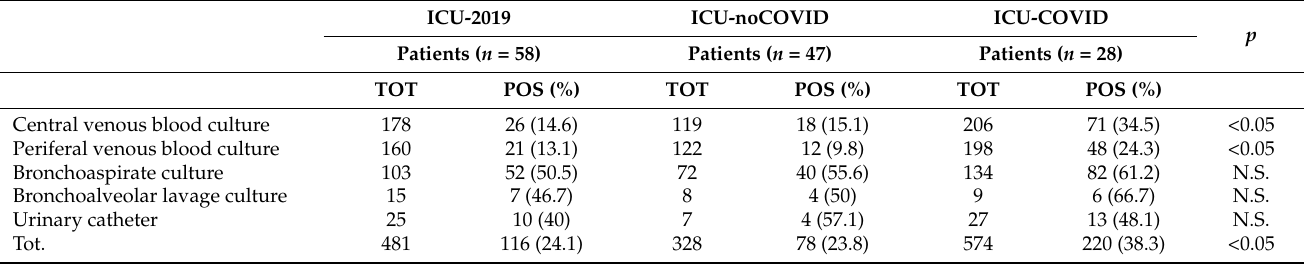
Table 1. Microbial cultures in patients.